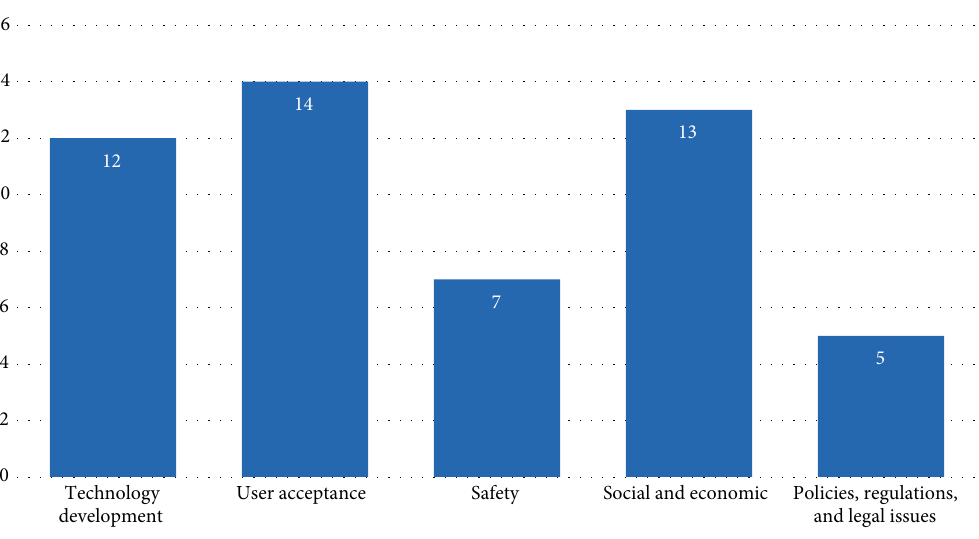
Figure 3: Number of reviewed studies per year and study location ( 𝑛 = 40 ; some studies counted multiple locations).